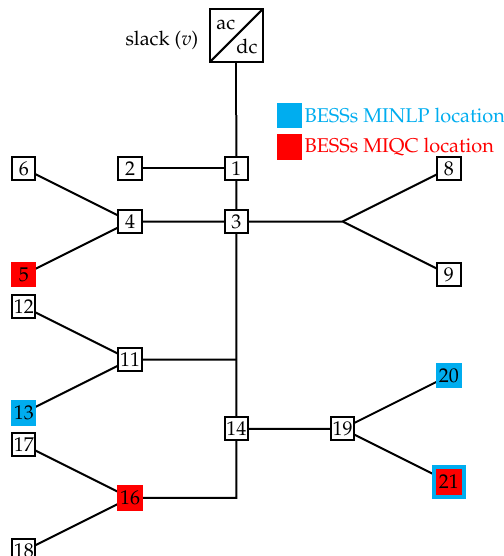
Figure 5. BESSs’ locations obtained with the exact MINLP and the proposed MIQC